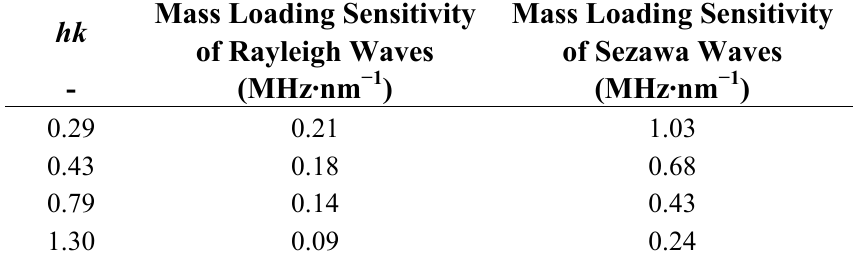
Table 4. Estimated mass loading sensitivities of Rayleigh and Sezawa waves for SU-8 film loading.